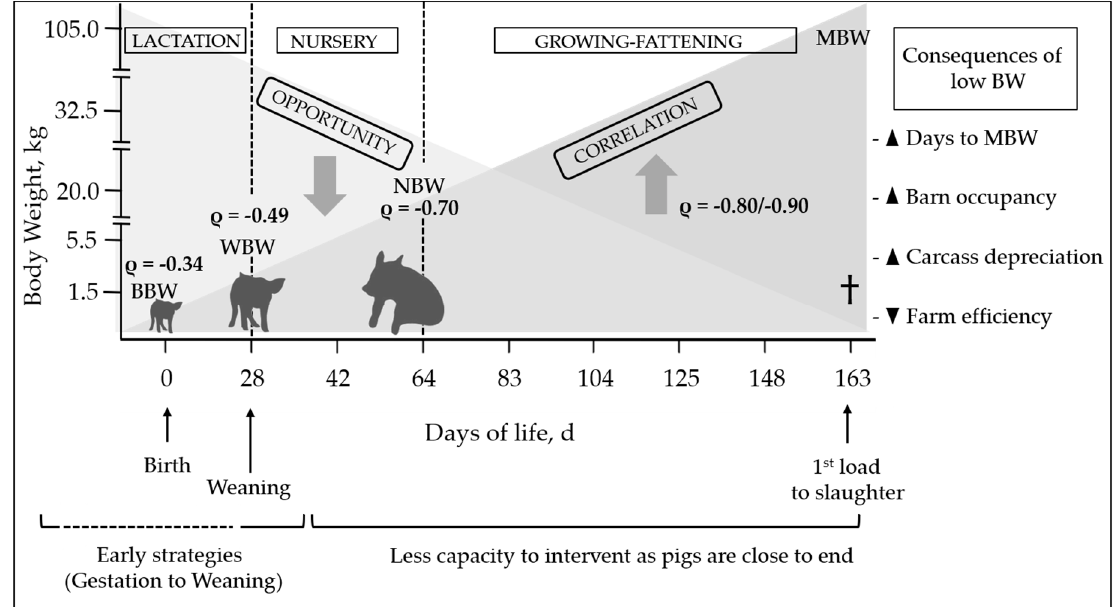
Figure 1. Effect of birth and weaning body weight until slaughter. The spearman correlation coefficient ( ρ ) indicates the correlation between body weights at different production phases with the number of days to reach a market body weight of 105 kg. BBW: birth body weight; WBW: weaning body weight; NBW: nursery body weight; MBM: market body weight. † means slaughter house Adapted from [2,7].